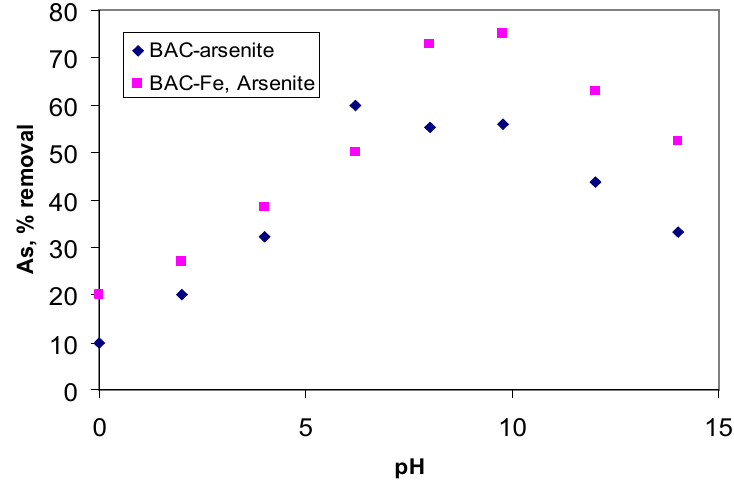
Figure 7. Study of arsenite adsorption by the BAC-Fe and BAC-Fe sorbents as a function of pH conditions: 100 μg L -1 arsenite, pH